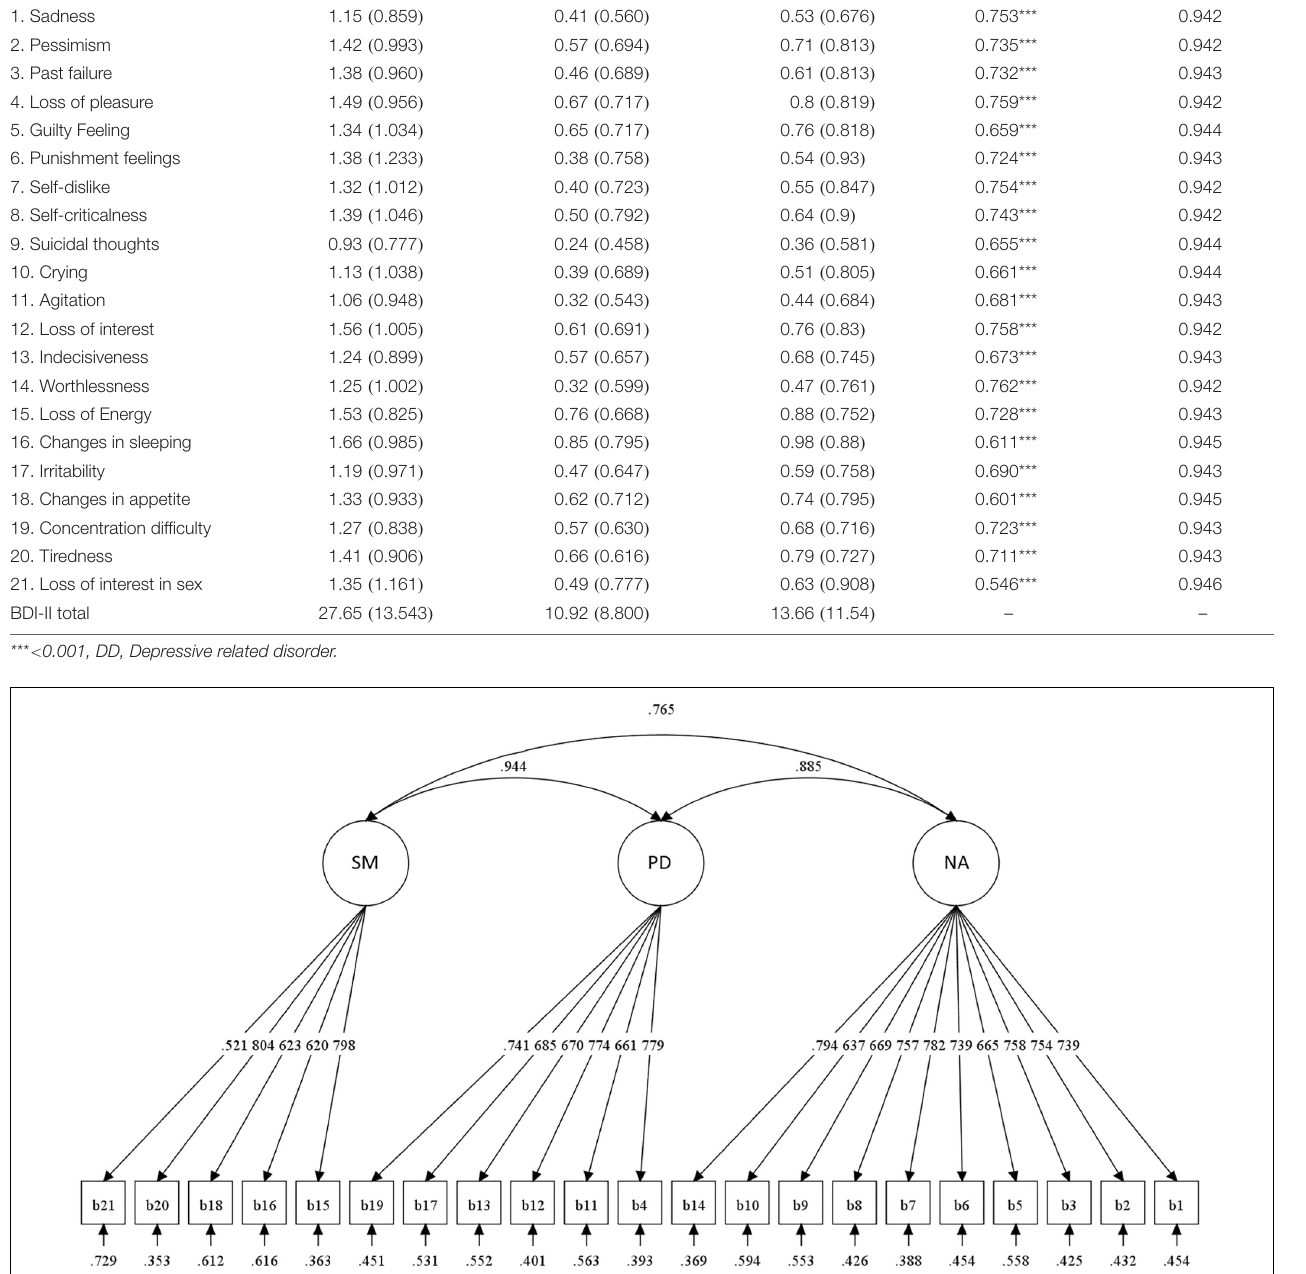
coefficients of Cronbach’s alpha ranged from 0.942 to 0.946 if individual items were deleted, suggesting that there is no significant benefit from excluding any individual items ( Table 2